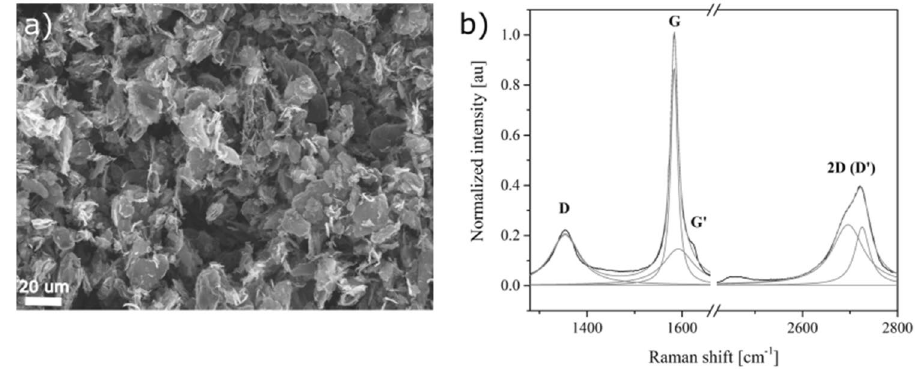
Figure 1. SEM photograph ( a ) and Raman spectrum with band assignment ( b ) of agglomerates of xGnP H-5 (XG Sciences, Inc., USA) graphene nanoplatelets, which were later used as a